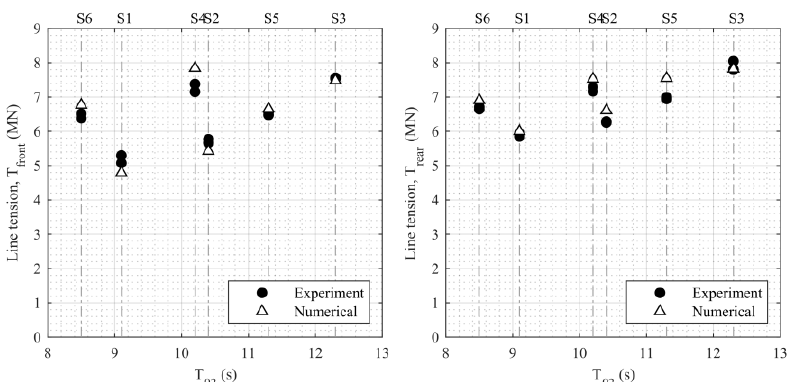
Figure 19. Comparison of mooring line tensions determined from experiments and numerical model in full scale values for series M2 Front mooring ( left ) and rear mooring ( right ).